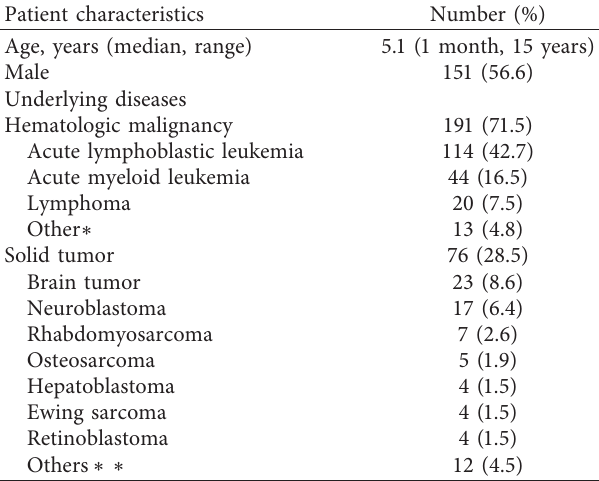
Table 1: Demographic data of 267 patients with febrile neutropenia. Patient